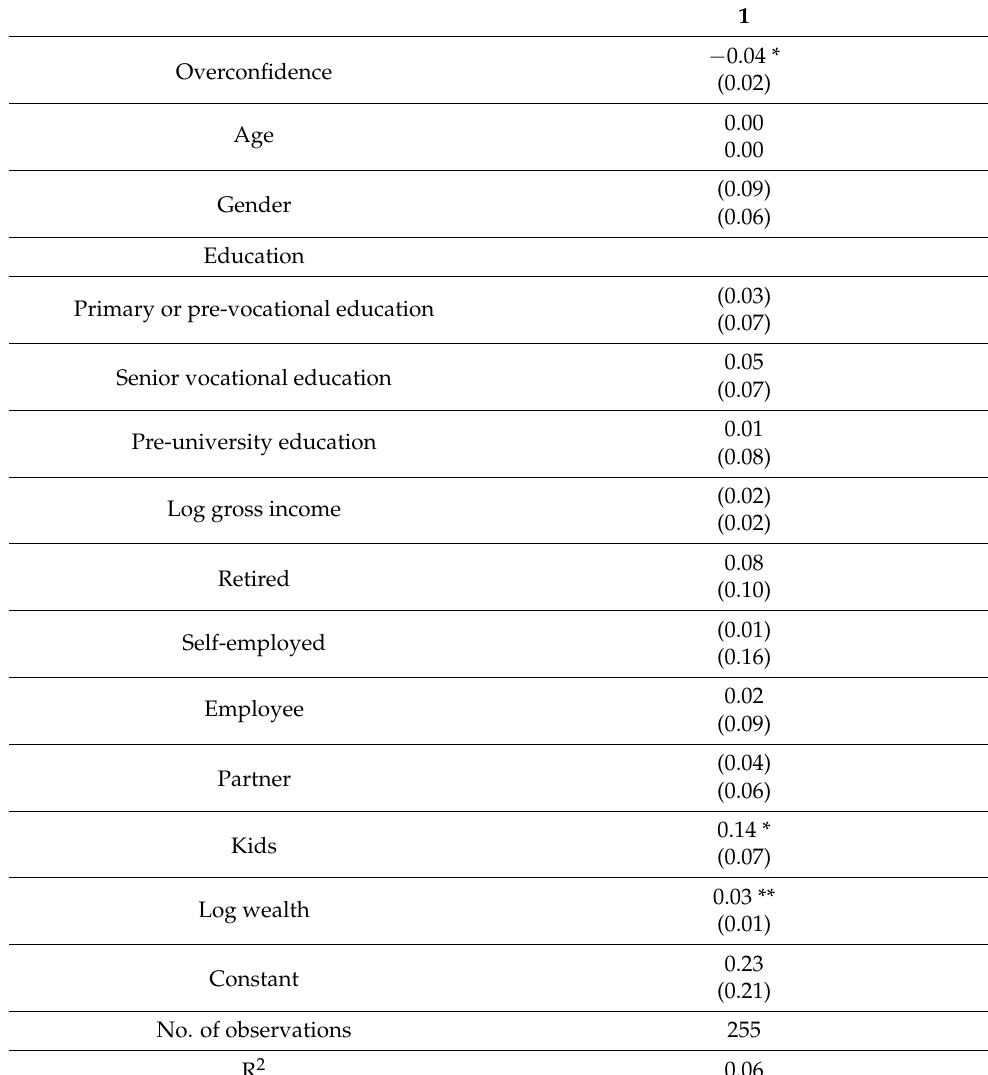
Table 4. Overconfidence and Financial Advice